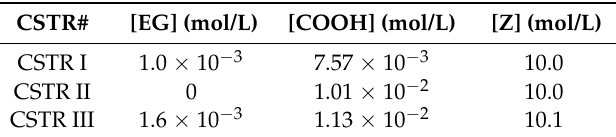
Table 3. Initial estimated values for the